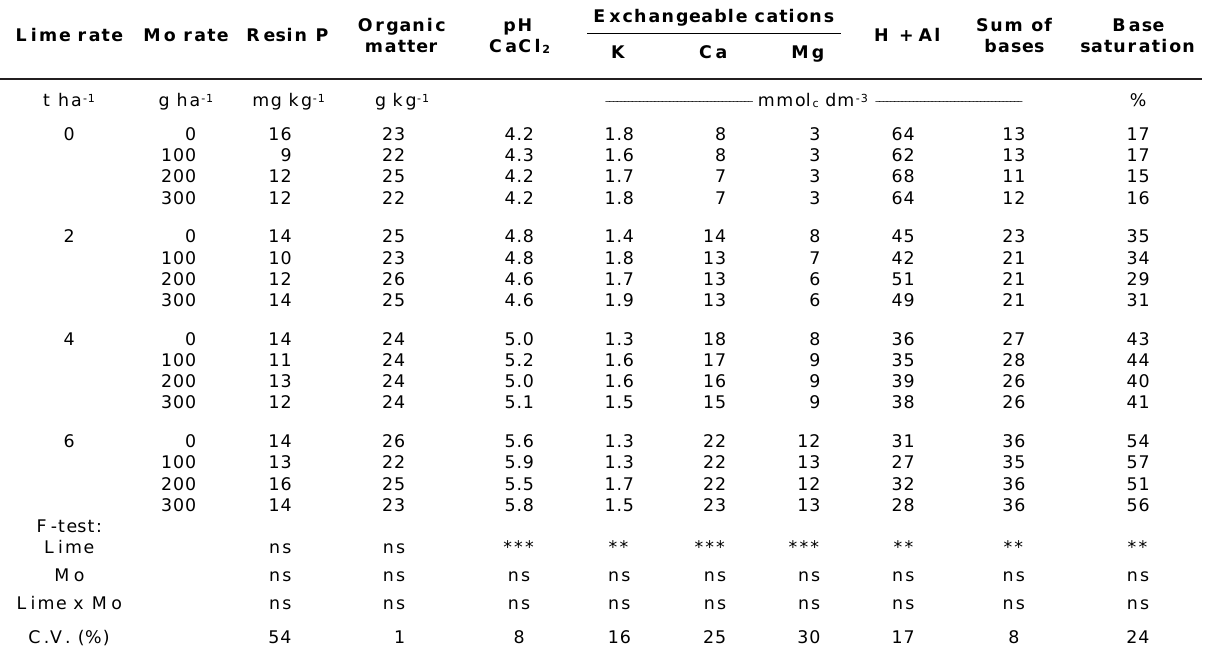
Table 1. The effect of lime and Mo and their interactions on the soil chemical characteristics one year after